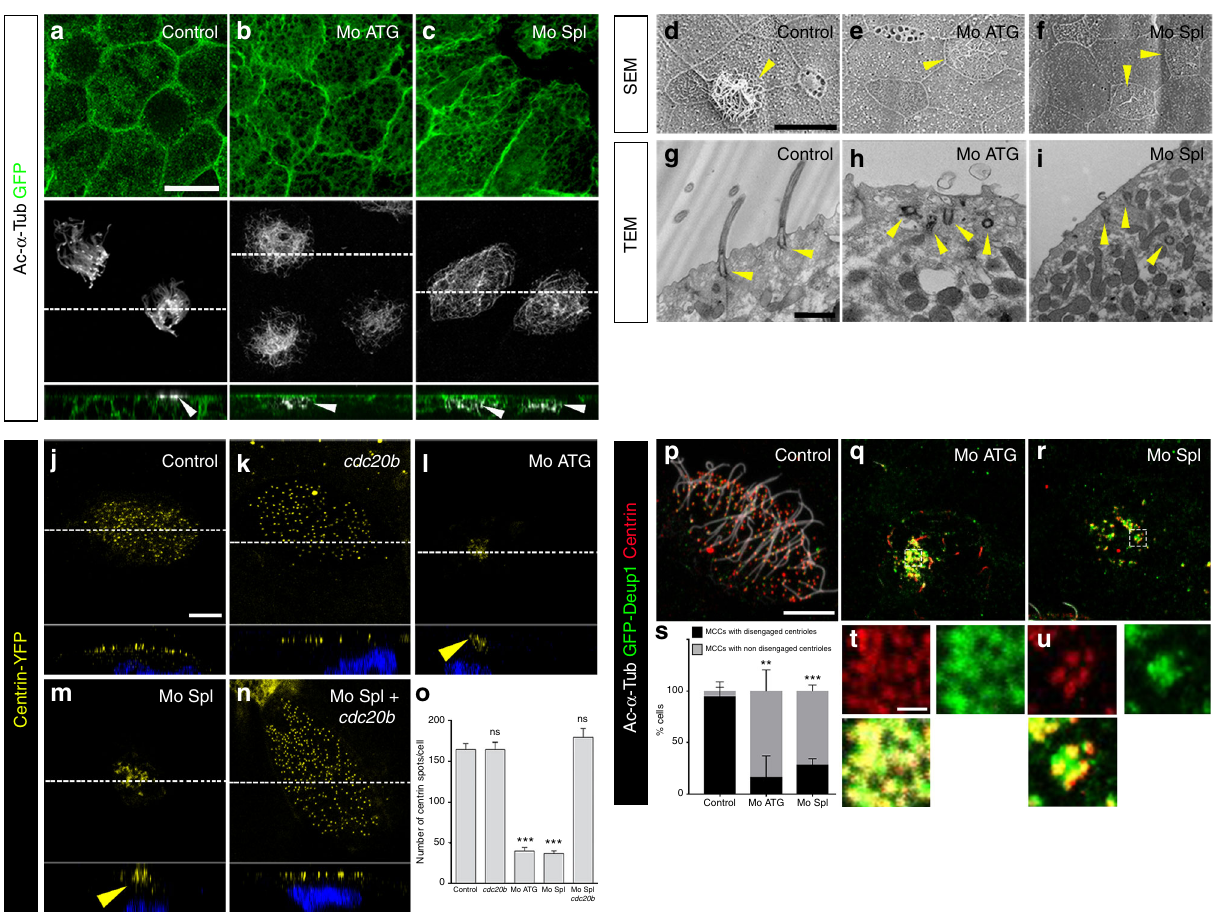
Fig. 5 cdc20b knockdown impairs multiciliogenesis in Xenopus epidermal MCCs. a – c 8-cell embryos were injected in presumptive epidermis with GFP-CAAX mRNA and cdc20b morpholinos, as indicated. Embryos at tailbud st25 were processed for fl uorescent staining against GFP (injection tracer, green) and Acetylated- α -Tubulin (Ac- α -Tub, cilia, white). White dotted lines indicate the position of orthogonal projections shown in bottom panels. Note that cdc20b morphant MCCs display cytoplasmic fi laments but do not grow cilia (white arrowheads). d – f Scanning electron microscopy (SEM) of control ( d ) and cdc20b morphant ( e , f ) embryos at tadpole st31. Yellow arrowheads point at normal ( d ) and defective MCCs ( e , f ). g – i Transmission electron microscopy (TEM) of control ( g ) and cdc20b morphant ( h , i ) embryos at tailbud st25. Yellow arrowheads point at normally docked basal bodies supporting cilia ( g ) and undocked centrioles unable to support cilia ( h , i ). j – n 8-cell embryos were injected in presumptive epidermis with centrin-YFP mRNA, cdc20b morpholinos, and cdc20b mRNA, as indicated. Centrin-YFP fl uorescence was observed directly to reveal centrioles (yellow). Nuclei were revealed by DAPI staining in blue. White dotted lines indicate the position of orthogonal projections shown in bottom panels. Yellow arrowheads point at undocked centrioles. o Bar graph showing the mean number of BBs per MCC, and standard error mean, as counted by Centrin-YFP dots. One-way ANOVA and Bonferroni ’ s multiple comparisons test on two experiments, *** p < 0.0001. cdc20b knockdown signi fi cantly reduced the number of BBs per cell, and this defect could be corrected by cdc20b co-injection with Mo Spl. p – u Embryos were injected with Multicilin-hGR and GFP-Deup1 mRNAs, treated with dexamethasone at gastrula st11 to induce Multicilin activity, and immunostained at neurula st23 against Acetylated- α -tubulin (cilia, white), GFP (deuterosomes, green), and Centrin (centrioles, red). p Control cells showed individual centrioles, many of which had initiated ciliogenesis. Note that Deup1-positive deuterosomes were no longer visible at this stage. ( q , r , t , u ) cdc20b morphant MCCs showed procentrioles still engaged on deuterosomes and lacked cilia. In t and u , zooms were made on regions identi fi ed by dashed boxes in q and r . s Bar graph showing the mean percentage of cells that completed or not centriole disengagement with standard deviations. Three experiments were analyzed. Unpaired t -test: p = 0.0037 (Mo ATG, **), p = 0.0004 (Mo Spl, ***).